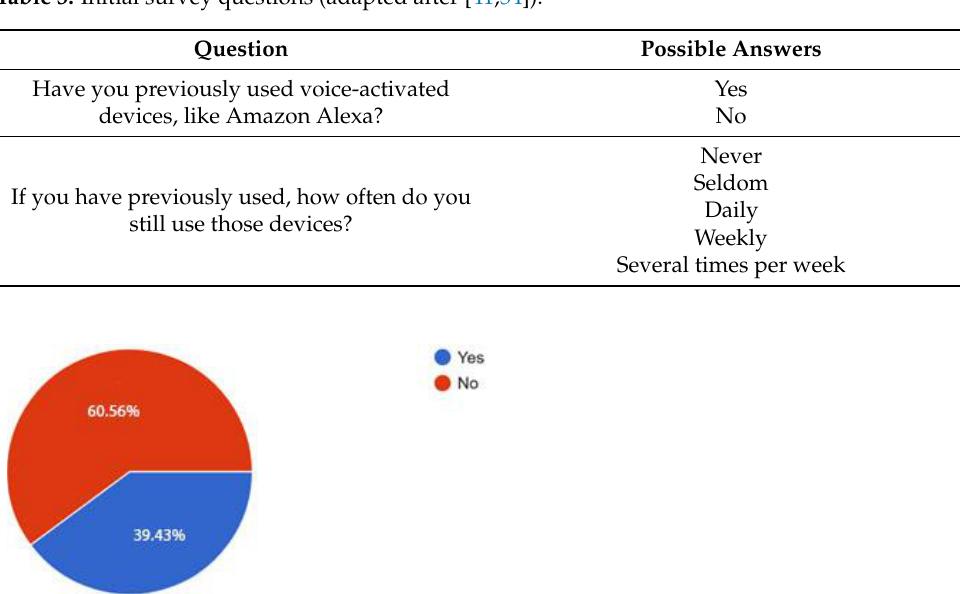
Figure 9. Successful execution of the system. Table 3. Initial survey questions (adapted after [41,54]).